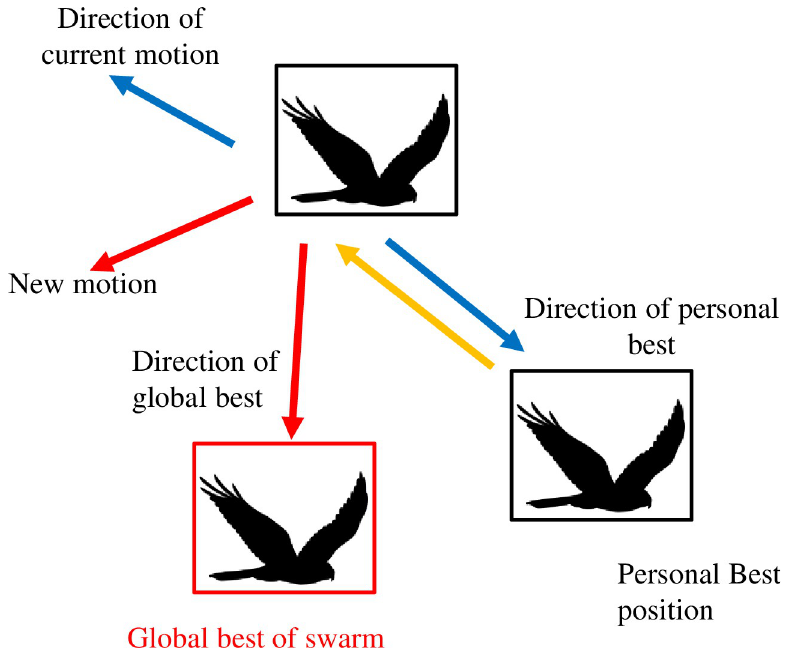
Fig 5. Particle movement by the swarm